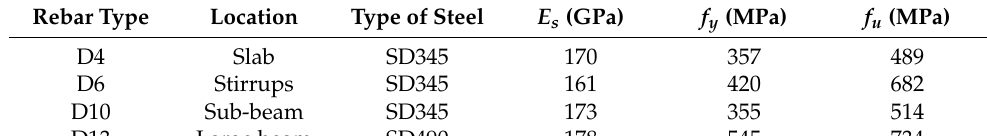
Table 3. Rebar properties.